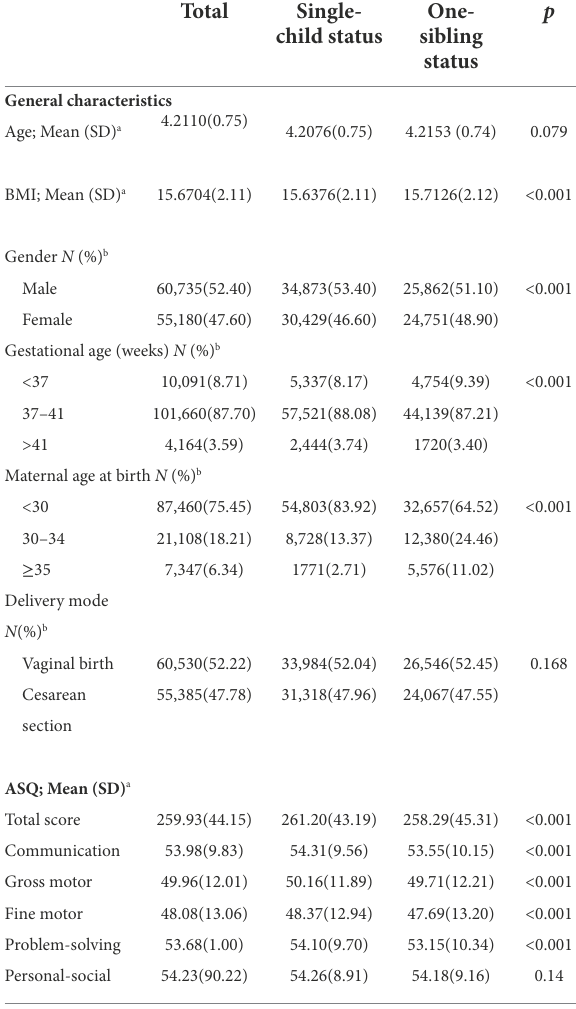
TABLE 1 The general characteristics and ASQ scores of preschool students ( N =